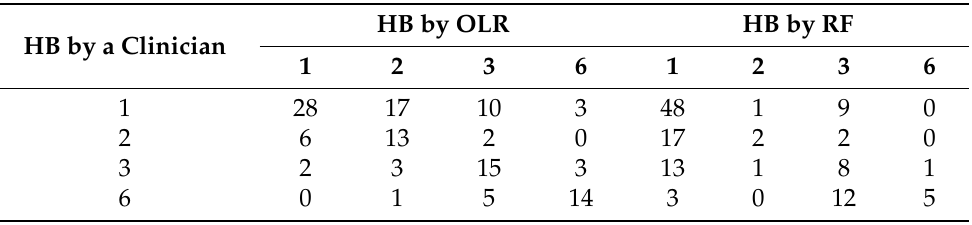
Table 2. Confusion matrix with numbers of (mis)classified cases by OLR model and random forest (RF) on a test set.